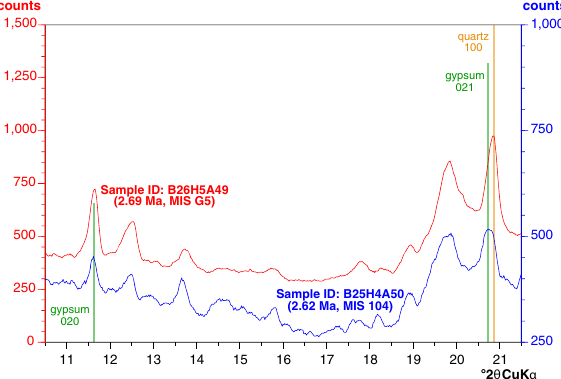
Fig. 10 Representative XRD patterns of analysis samples including gypsum. Main peaks (020, 021) of gypsum are clearly shown on XRD patterns of individual